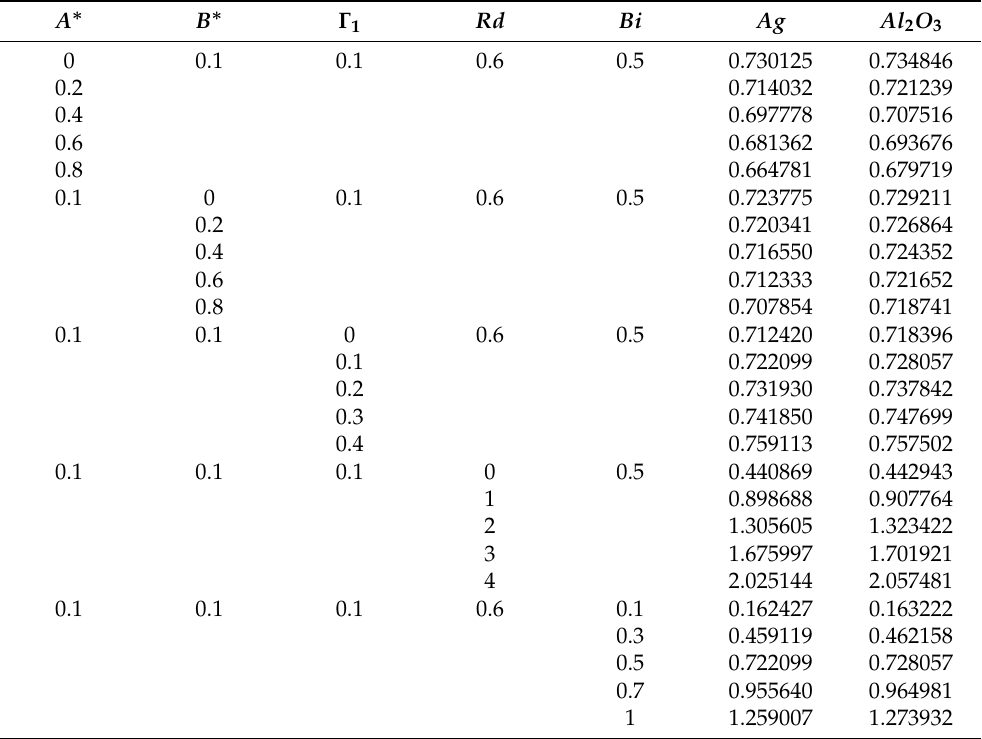
Table 6. Variations of LNN for a diverse combination of A ∗ , B ∗ , Γ 1 , Rd , Bi